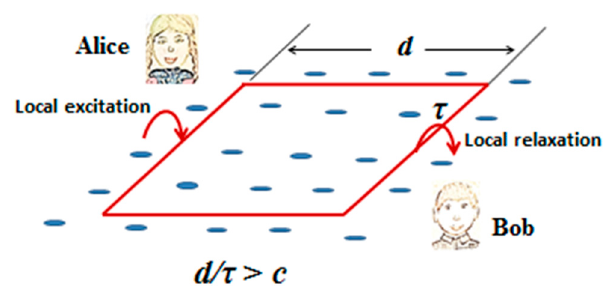
Figure 2. Gedanken experiment to show a potentiality for the spatially-discontinuous transition between two distant local states through an intermediate orbit-like macroscopic state. Here a macroscopic spatial discontinuity of the transition is due to the fundamental indivisibility of the intermediate macroscopic orbit-like state. d– the length of the side of a macroscopic square orbit, τ – electron lifetime at the orbit. Solid cycles shows schematically charged local scatterers.